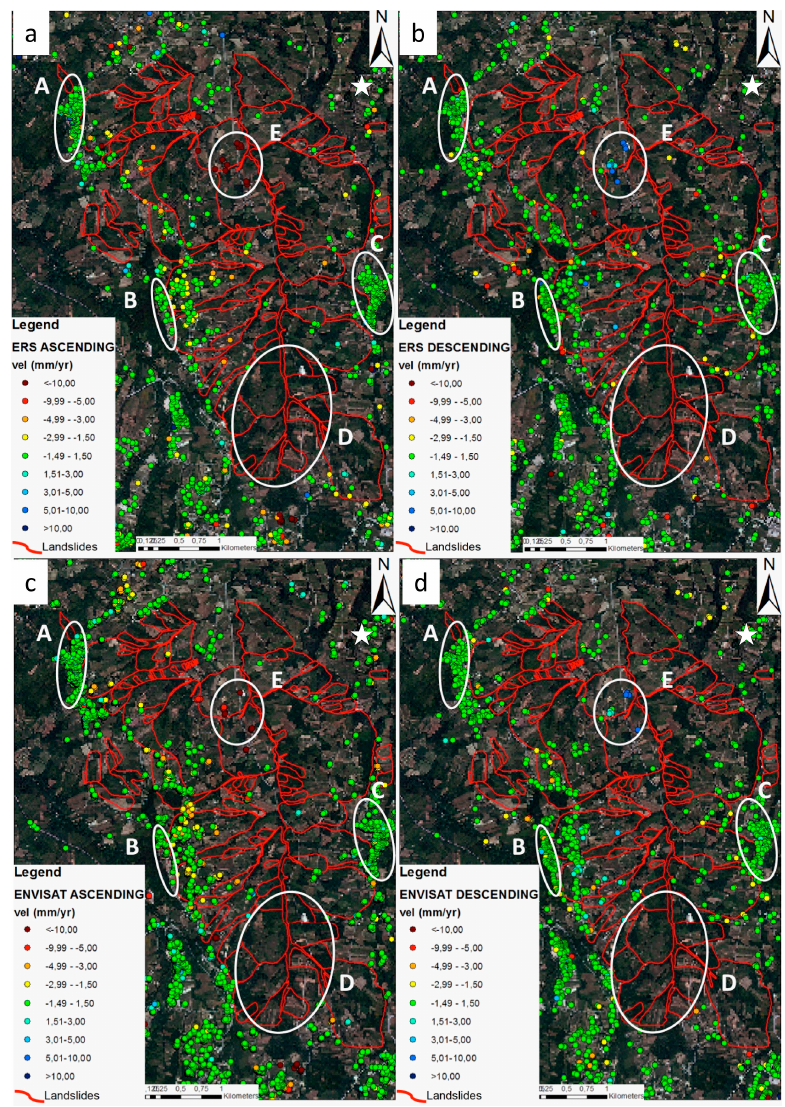
Figure 5. A-DInSAR results: ( a ) ERS ascending; ( b ) ERS descending; ( c ) Envisat asc; and ( d ) Envisat desc. PSs are presented as colored dots. Colors from yellow to red state displacements away from the satellite, while dots from light blue to dark blue state displacements toward the satellite. Values are expressed in millimeter/year. The white star indicates the location of the reference point. Red polygons indicate landslide bodies mapped thanks to aerial photos interpretation and field surveys. A, B and C ellipses indicate urbanized areas. D ellipse indicates an area where no PSs have been detected because of absence of good scatterers. E area indicates the area affected by strong horizontal displacements discussed in Section 4.4.